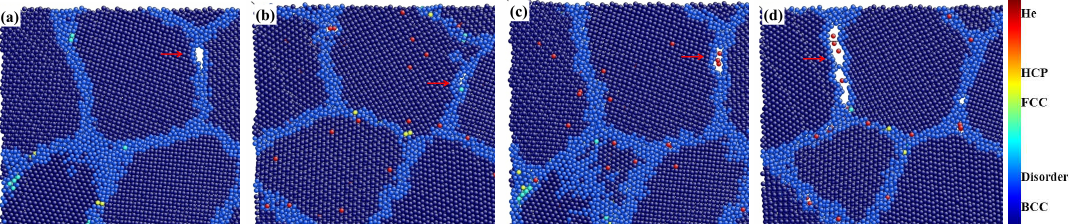
Figure 7. Cracks formed in the model ( a ) without He; ( b ) with BCC He (0.5%); ( c ) with uniform He (0.5%) and ( d ) with GB He (0.5%). The structures of Fe atom analyzed with the help of ACNA algorithm are colored according to the color map, and the red ball represents He